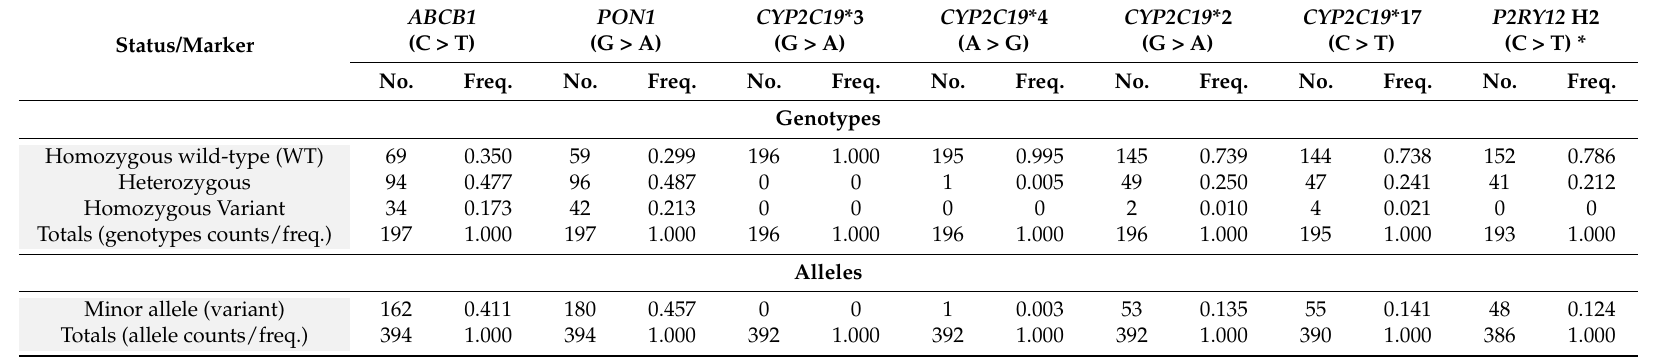
Table 1. Overall genotype and allelic frequencies of seven relevant polymorphisms in four pharmacogenes of interest (i.e., potentially to be associated with clopidogrel response) in the Puerto Rican population. Data correspond to genomic DNA specimens from the Puerto Rico newborn screening program (PRNSP) that were collected from different ethno-geographic regions across the Island of Puerto Rico. Totals are less than 200 due to poor DNA quality or non-calling. * tagSNP for calling (defining) the P2RY12 haplotype 2.